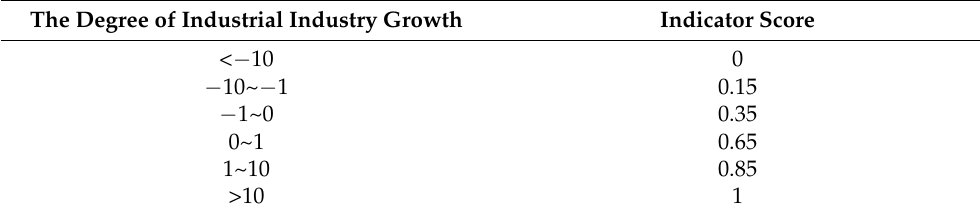
Table 1. Industrial industry growth degree scoring